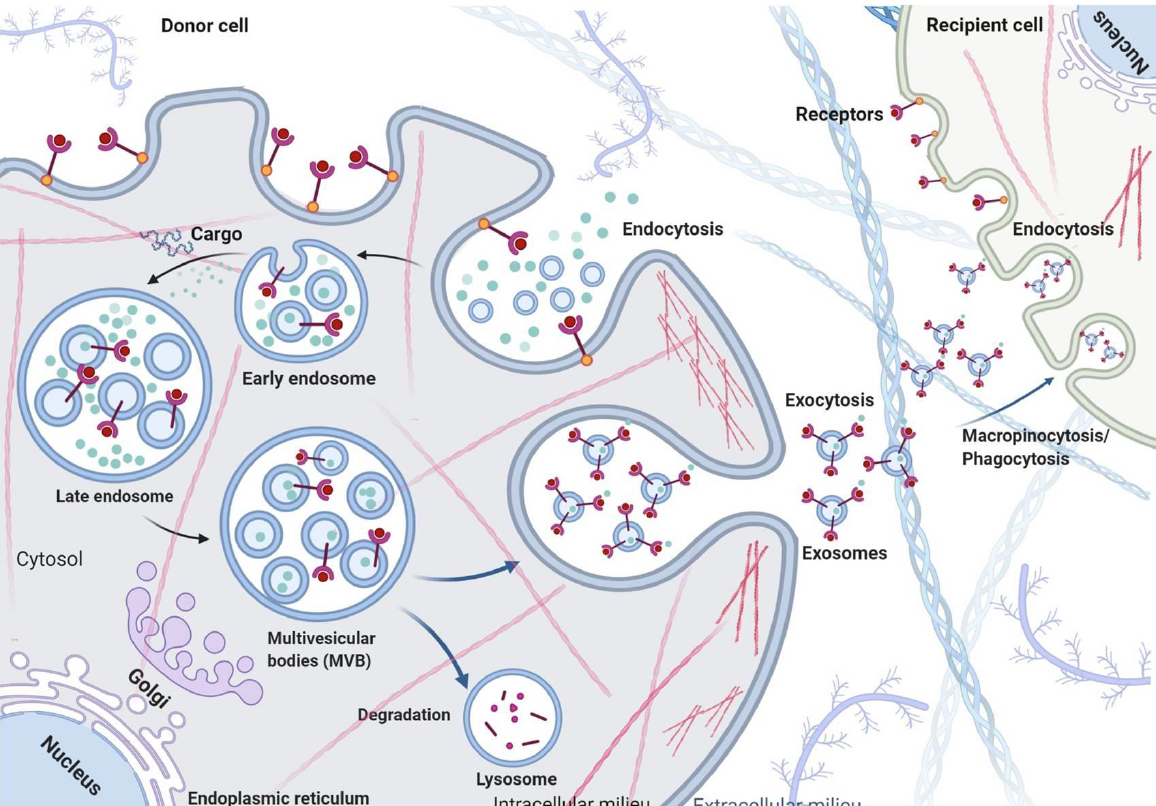
Figure 4. Exosome biogenesis, secretion and uptake. Extracellular milieu is composed of various components including proteins, lipids, small molecules, numerous metabolites, which enter the cell through the process of endocytosis. This process leads to the formation of early endosomes; cargo is wrapped into intraluminal vesicles within multivesicular bodies (MVB) upon inward budding of the membrane. Further, early endosomes are transformed into late endosomes, which later give rise to the multivesicular bodies. The modified multivesicular bodies have a cargo of extracellular milieu and cytoplasmic constitutes. Multivesicular bodies and their exosomal content can follow two primary pathways. In the first, they can be fused with autophagosomes and follow the degradation pathway through lysosomes. In the second pathway, multivesicular bodies can fuse to the plasma membrane through the microtubule and cytoskeletal network, and be released by budding from cytomembrane. Furthermore, the exosomes released through exocytosis interact with recipient cells through cell signaling molecules on their respective surfaces. Exosomes can also enter into recipient cells by employing different mechanisms such as endocytosis, macropinocytosis, phagocytosis and direct fusion of plasma membranes. Various proteins are involved in exosome biogenesis, secretion and uptake, include ESCRT, AAA ATPases, ESCRT-associated protein, SNAREs, Rabs, and other enzymes (Table 1).